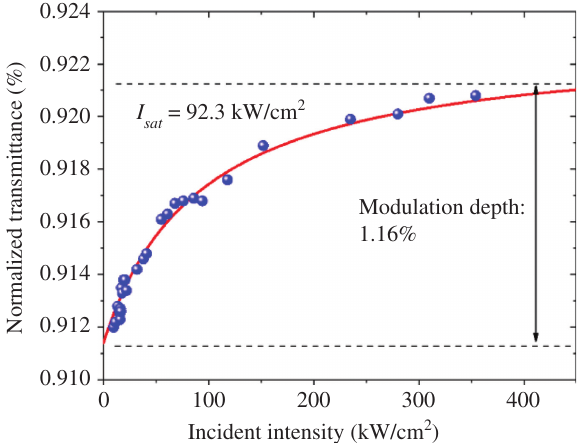
Figure 3: Nonlinear saturable absorption data and its corresponding fitting curve.